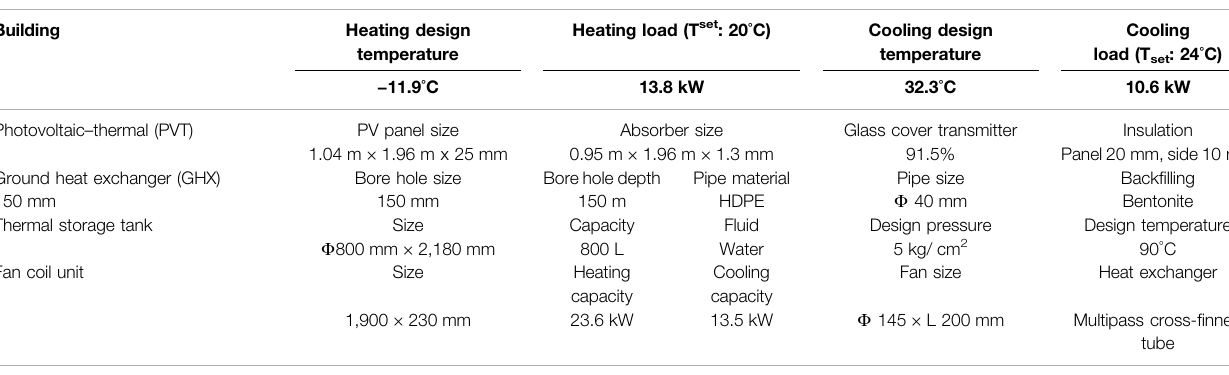
TABLE 1 | Hybrid solar – geothermal polygeneration components (Nam et al., 2018). Building